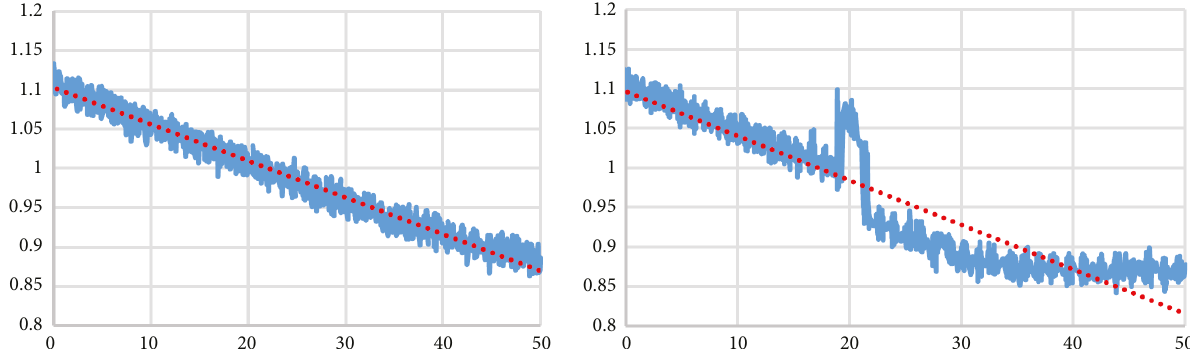
Figure 3: Dependence of the accelerometer Z-axis values (1g – 9.81 m/s 2 ) upon the temperature during slow (1 ∘ C/min) heating (left) and cooling (right).